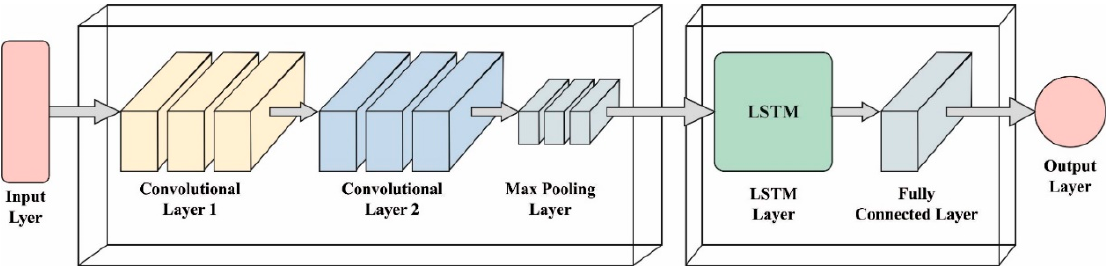
Figure 1. Structure of